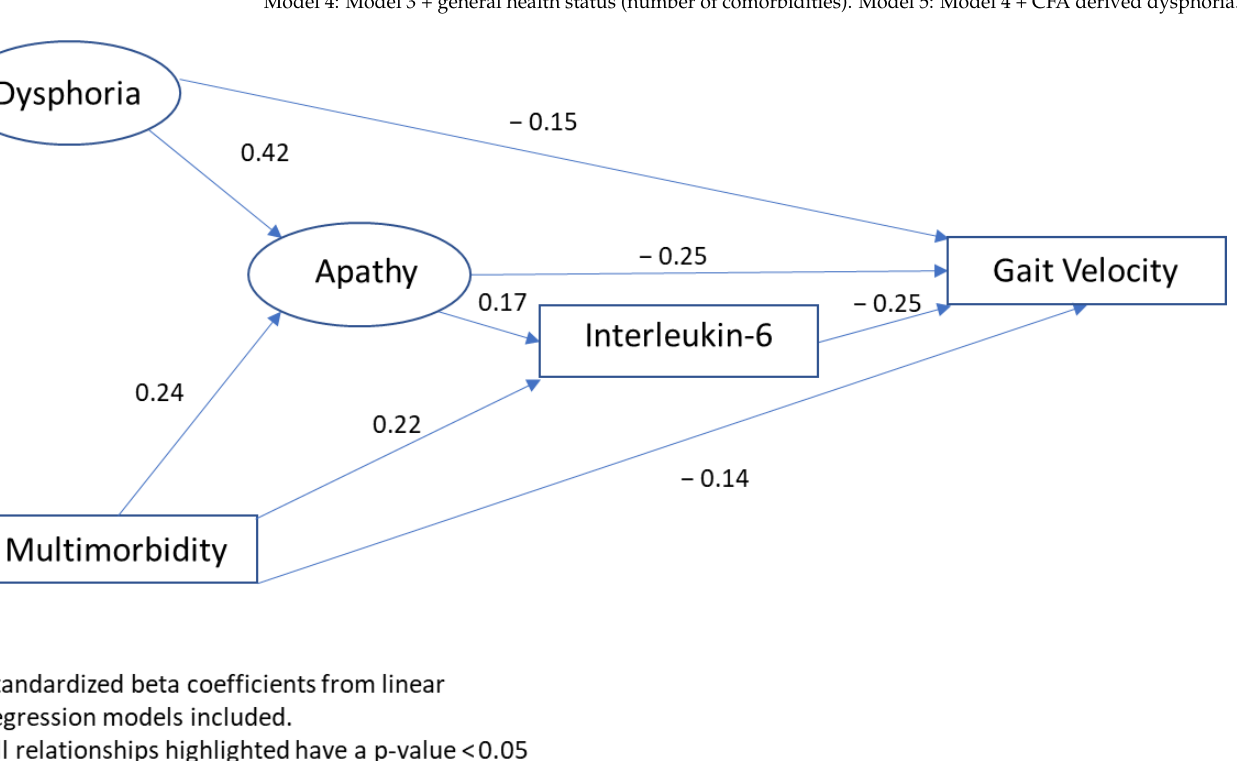
Figure 1. Path diagram of direct and indirect variable effects on gait velocity.